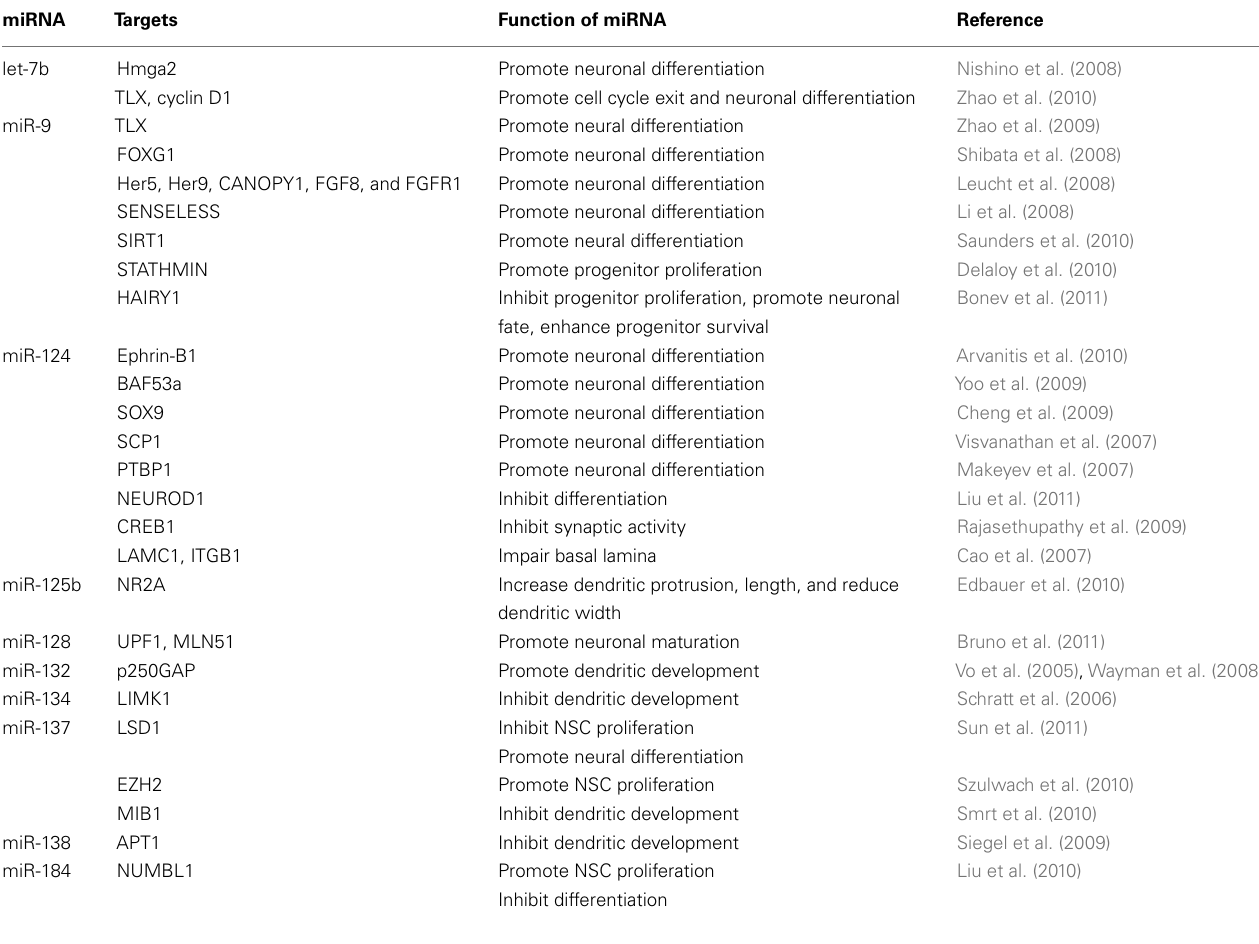
Table 1 | MiRNAs involved in